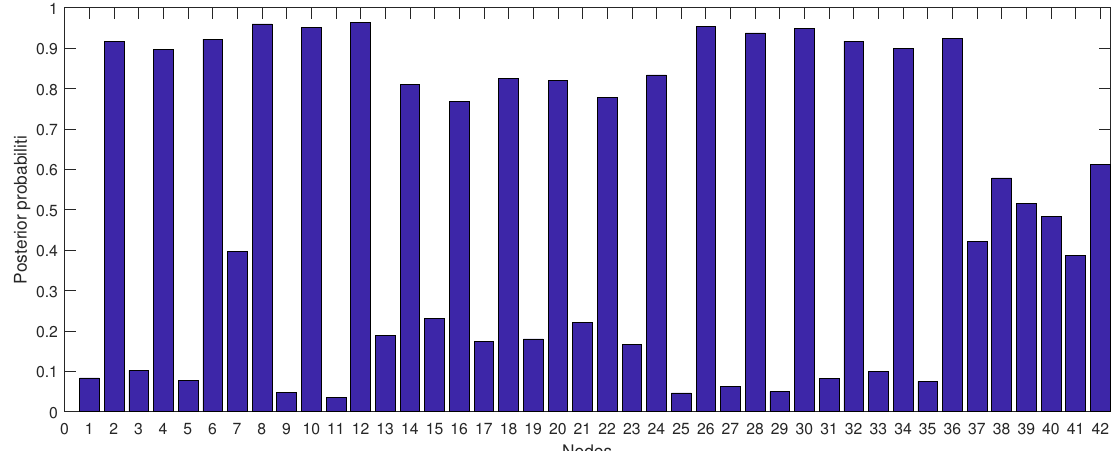
Figure 9. The posterior probabilities of all nodes where bars 1 to 42 represents the posterior probabilities of nodes A > 24 m (OTW), A ≤ 24 m (OTW), A > 24 m (OTUS), A ≤ 24 m (OTUS), A > 24 m (OTS), A ≤ 24 m (OTS), B > 3 setts/km − 2 (OTW), B ≤ 3 setts/km − 2 (OTW), B > 3 setts/km − 2 (OTUC), B ≤ 3 setts/km − 2 (OTUC), B > 3 setts/km − 2 (OTS), B ≤ 3 setts/km − 2 (OTS,) C > 6 months (OTW), C ≤ 6 months (OTW), C > 6 months (OTUC), C ≤ 6 months (OTUC), C > 6 months (OTS), C ≤ 6 months (OTS), D > 3 heads/ha (OTW), D ≤ 3